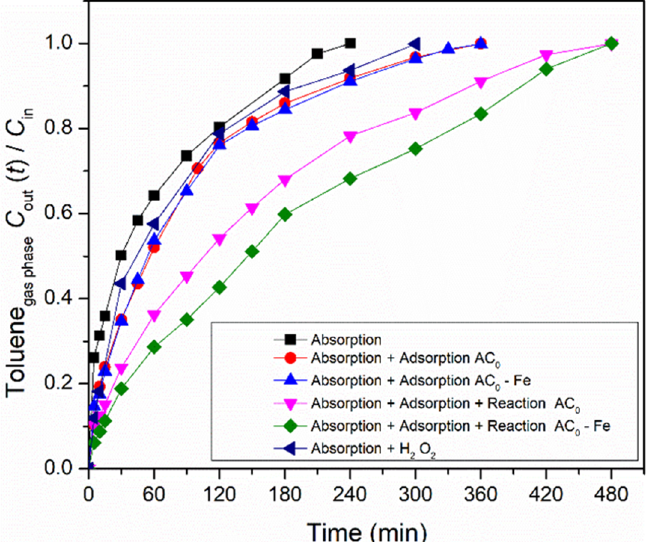
Figure 3. Screening of all processes (absorption, adsorption and reaction) that occurred during toluene removal/degradation by heterogeneous Fenton oxidation with AC 0 -related materials. Experimental conditions (when applicable/used) were as follows: pH 0 = 3.0, [H 2 O 2 ] = 0.005 mol dm − 3 , [modified activated carbon/iron-based catalyst] = 0.75 g dm − 3 , Q air = 0.15 dm 3 min − 1 .